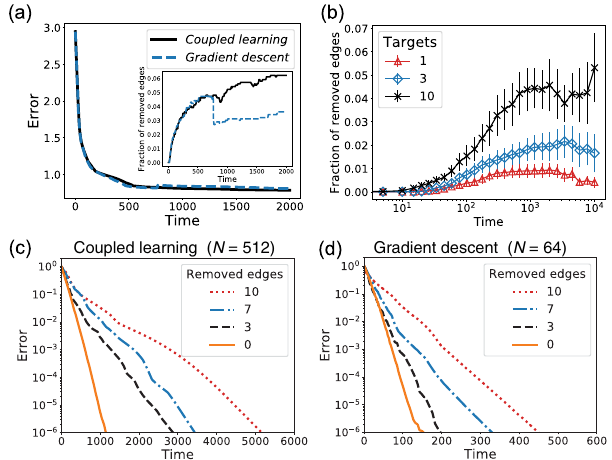
FIG. 9. Effects of non-negative learning degrees of freedom. (a) Training a flow network ( N ¼ 512 ; M S ¼ 10 ; M T ¼ 10 ) on a “ hard ” task where learning only reduces the error by a small factor. We find that when coupled learning fails to train a flow network, gradient descent (tuning) fails as well, suggesting the issue lies with the network and not the learning rule. Inset shows that a few percent of edges (conductances) reach their minimal value during training. (b) Averaging over 10 training tasks, we find that harder training problems with more simultaneous targets induce a larger fraction of edges to reach their minimal value. (c) Median normalized error during training with coupled learning for networks with different number of vanishing edges, showing that the non-negative constraint slows learning ( N ¼ 512 ; M S ¼ 10 ; M T ¼ 5 ). (d) A similar slowdown arises when the network is trained with standard gradient descent ( N ¼ 64 ; M S ¼ 10 ; M T ¼ 5